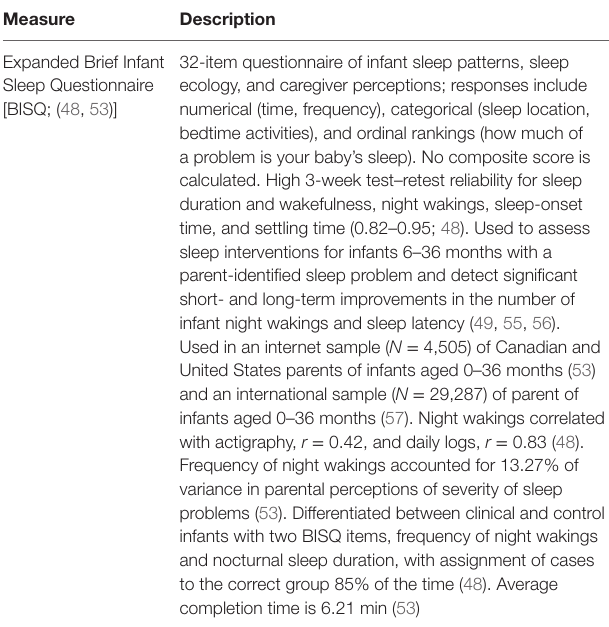
taBlE 2 | Measure for primary (frequency of night wakings) and secondary (nocturnal wakefulness, sleep latency, longest consolidated sleep episode, and parental perception of problematic infant sleep)